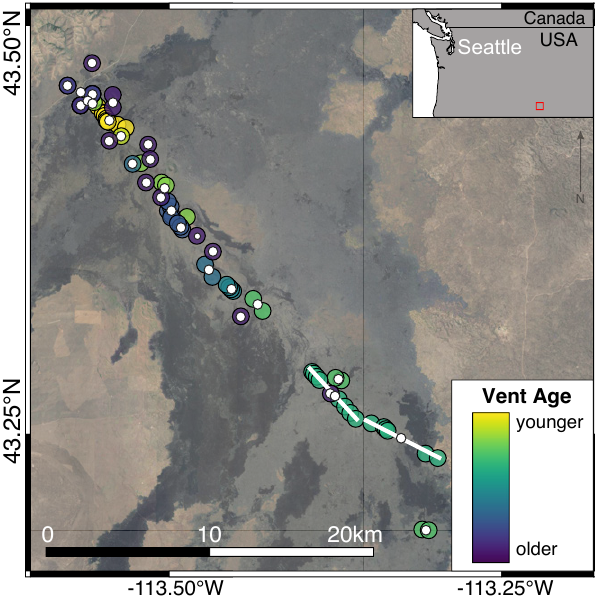
Figure 9: Map showing vent and event locations for Craters of the Moon, Idaho, USA (modified from Cham- pion et al. [1989] and Kuntz et al. [1989a], b, 1990. The coloured dots indicate the locations and relative ages of mapped vents, while the white dots show the location of calculated events. The white lines show the align- ment of linear clusters calculated by the event mod- elling code. Map background data: Google, Landsat/-